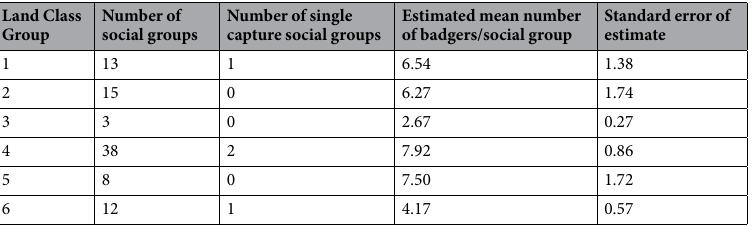
Table 1. Estimates of the mean number of badgers per social group in each Land Class Group, the total number of social groups sampled in each Land Class Group and the number of those social groups at which only one badger was identified. Land Class Group 7 was not included because no main setts were recorded in any of the surveyed squares in this Group during the 2011–13 sett